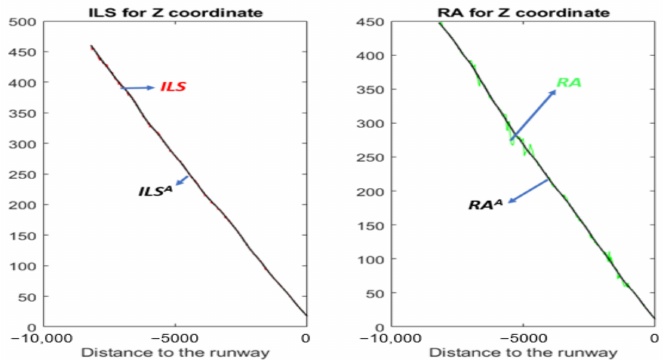
Figure 9. ILS, ILS L , RA, and RA L for the Z coordinate (real values of a